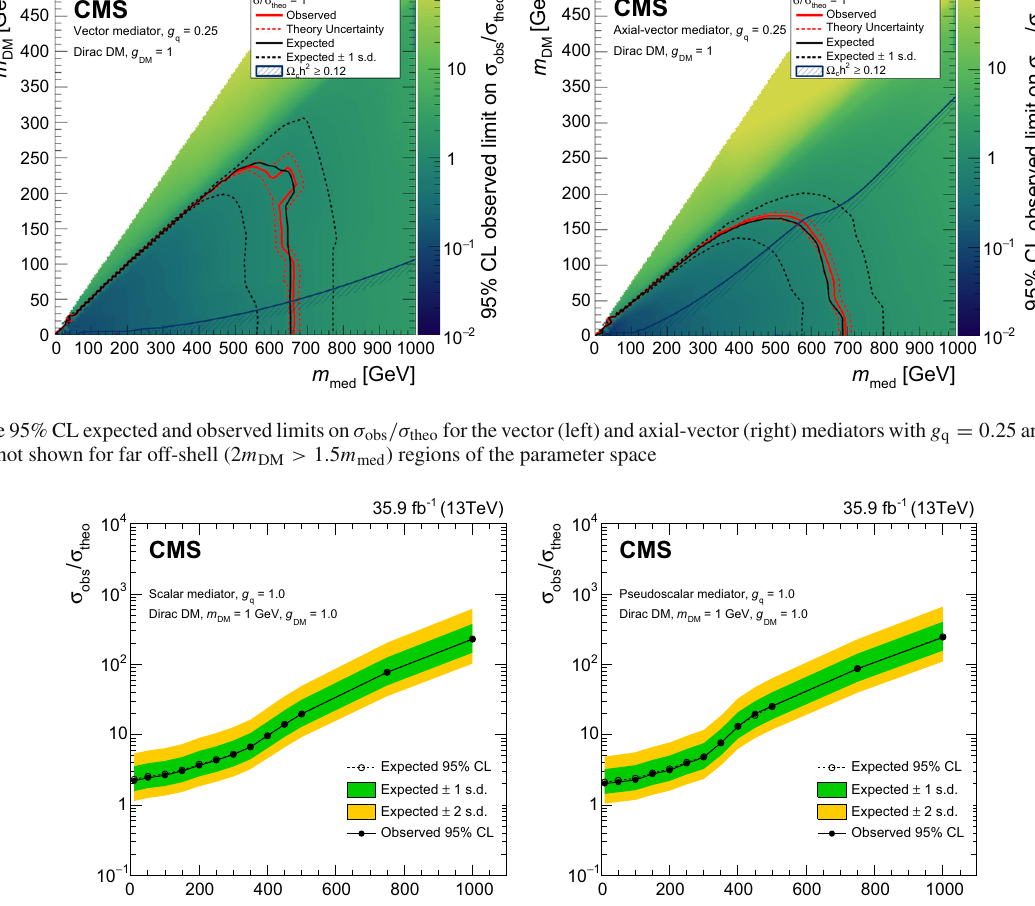
both are treated together when obtaining the final